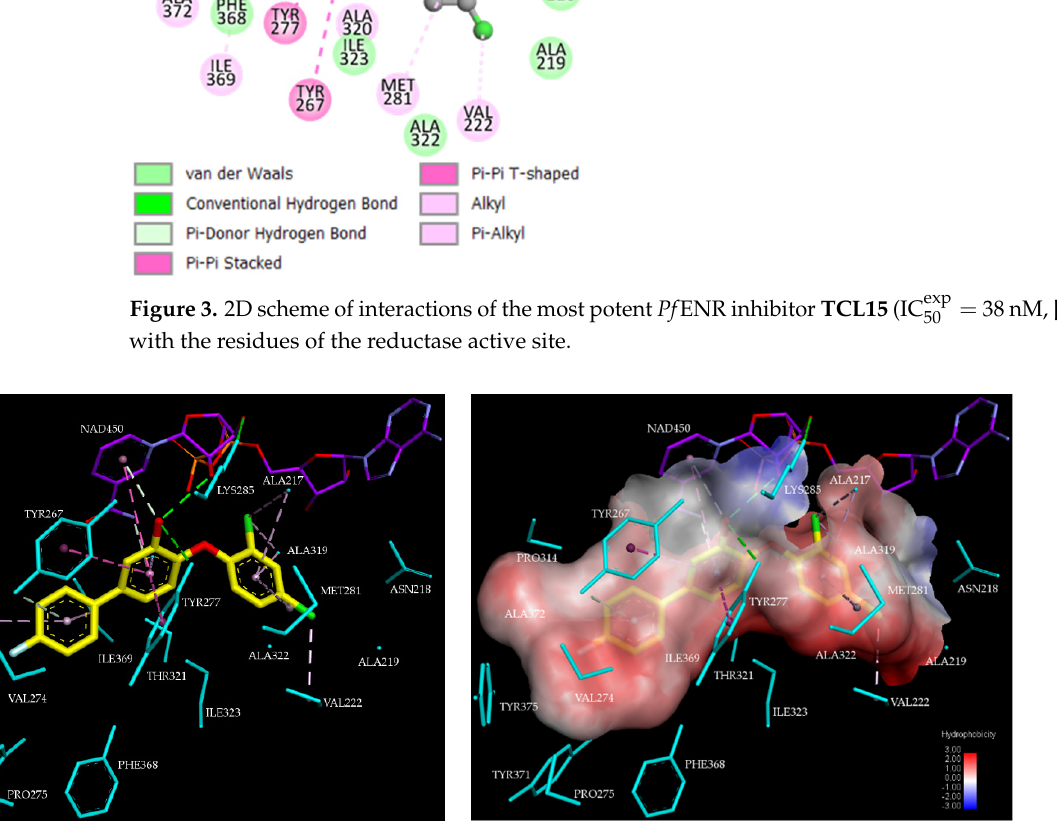
Figure 4. ( Left ) 3D structure of the active site with the most potent inhibitor TCL15 ( IC (cid:2873)(cid:2868)(cid:2915)(cid:2934)(cid:2926) (cid:3404) 38 nM, [21]). The carbon atoms are coloured yellow; the residue side chains and carbon atoms of the NAD cofactor are coloured cyan and purple, respectively. Interaction colour code: hydrogen bonds (green), hydrophobic contacts of alkyl groups (pink), π - π interactions (dark pink). ( Right ) Molecular surface of the active site of Pf ENR. Surface colouring legend: red, hydrophobic; blue, hydrophilic; white, intermediate.